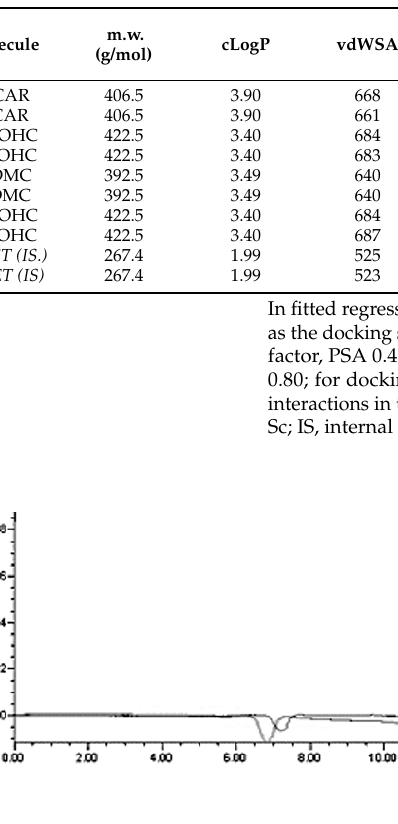
Figure 10. Experimental determination of the elution order: separate runs using the same chroma- tographic conditions for S -CAR (retention time, 26.7 min) and R -CAR (retention time, 30.5 min). The amount injected per run: 1 ng = 10 μ L of a 100 ng/mL solution. The chromatographic conditions are: mobile phase consisting of 80% organic modifier (87% acetonitrile: 13% methanol) and phosphate buffer pH 7, delivered at a flow rate of 0.5 mL/min, temperature at 25 °C.